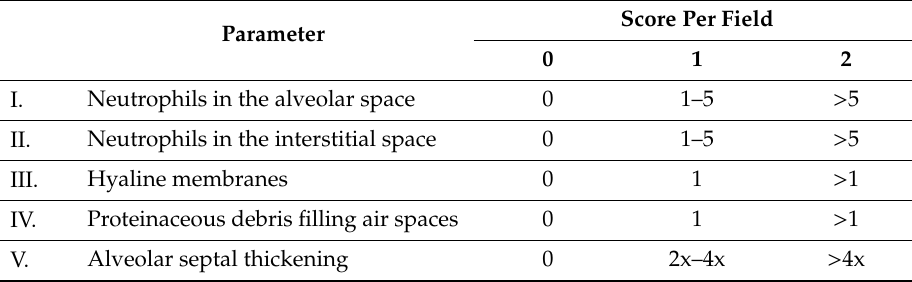
Table 1. Parameters for lung injury